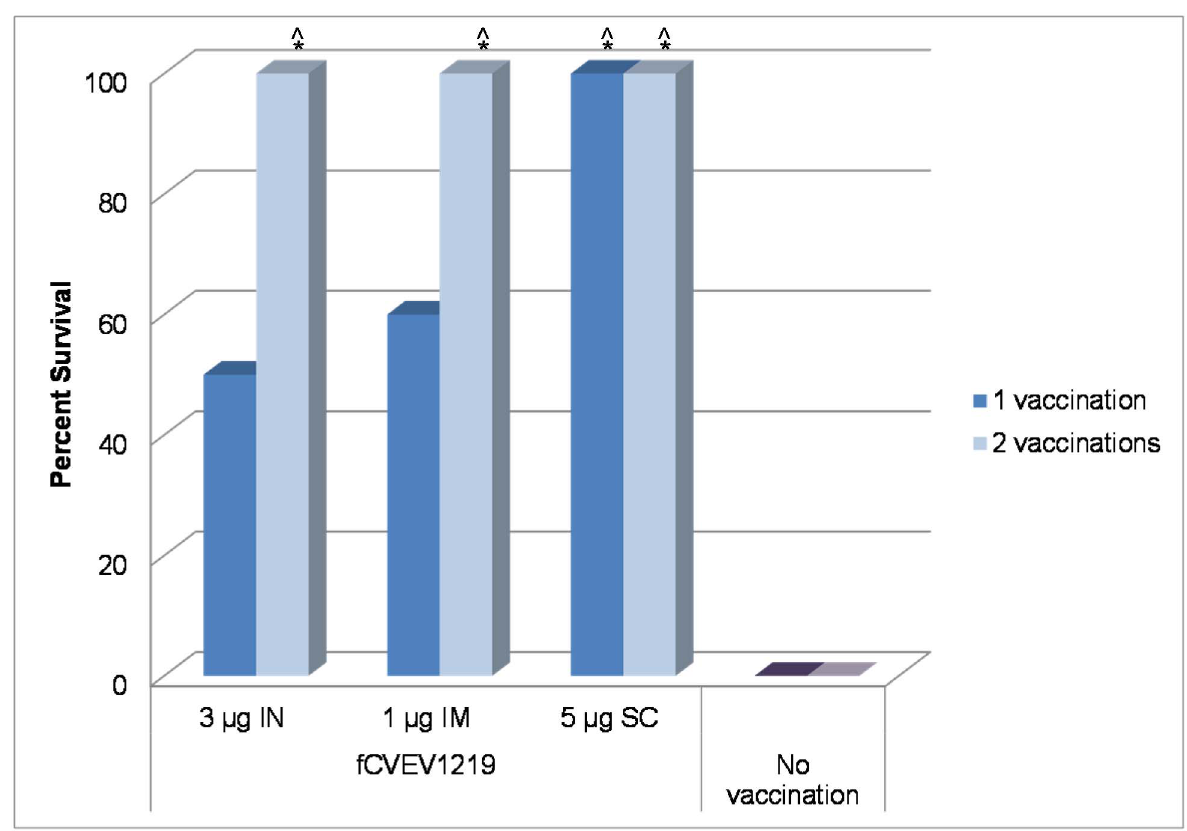
Figure 8. Protective efficacy of fCVEV1219 vaccine candidate when administered on an extended vaccination schedule with aerosol challenge. Groups of BALB/c mice (n=10) were administered one (dark bars) or two doses (light bars) of fCVEV1219 at doses ranging from 5–1 m g by IN, IM, or SC routes. Half of the mice were challenged by aerosol, with at least 100LD 50 of EEEV strain FL93-939, 63 days after the first vaccination, while the other half were challenged 28 days after the second vaccination (d84). Mice were monitored for 28 days post-challenge for mortality and clinical signs of disease (*p-value , 0.05 for pairwise comparison to control group; ‘ p-value , 0.05 for pairwise comparison to IND vaccine group from the first study).